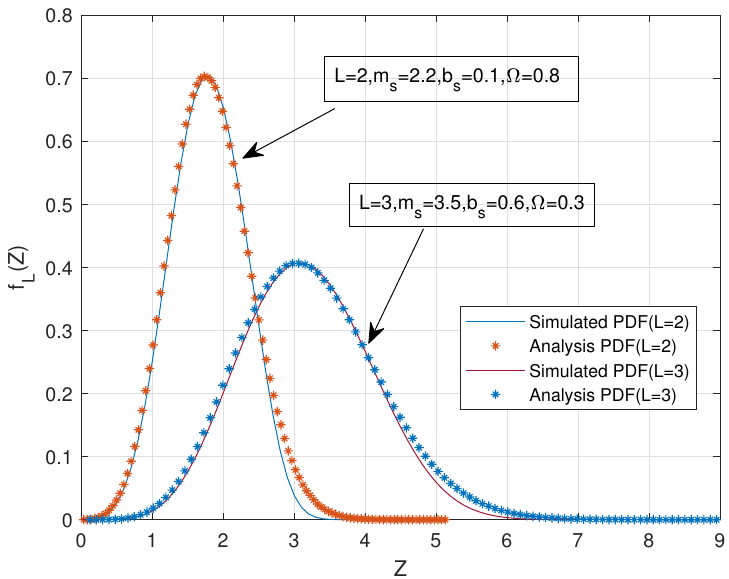
Figure 3. Analytical and simulated PDFs of the EGC scheme in SR fading